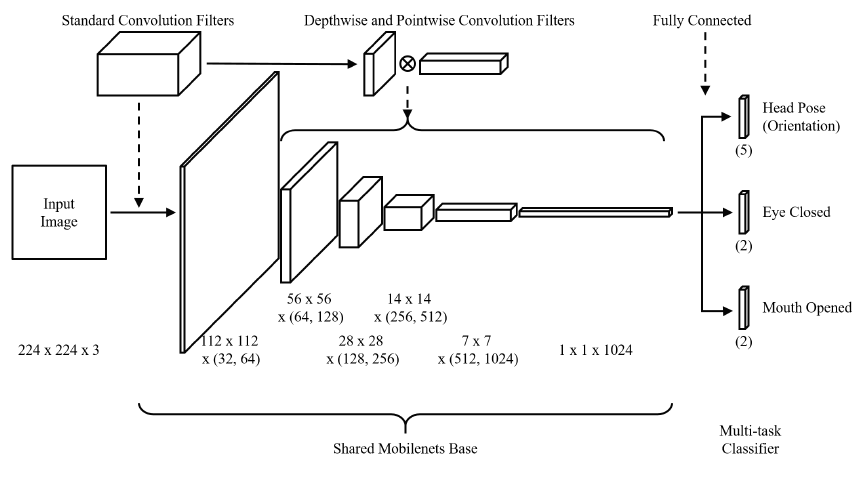
Figure 12. Multi-task